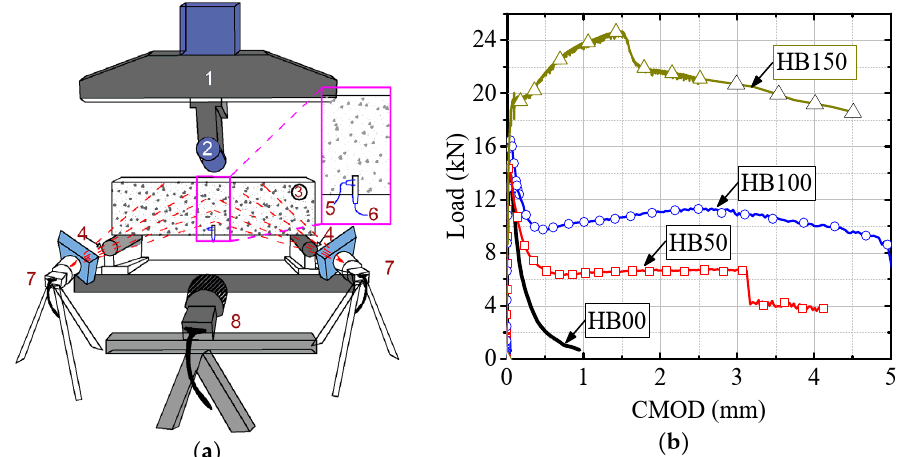
Figure 2. Fracture test. ( a ) Fracture test setup. 1. Actuator. 2. Loading jig. 3. FRC specimen. 4. Roller supports. 5. CTOD gauge. 6. CMOD gauge. 7. Light source. 8. DIC camera. ( b ) Load versus CMOD.